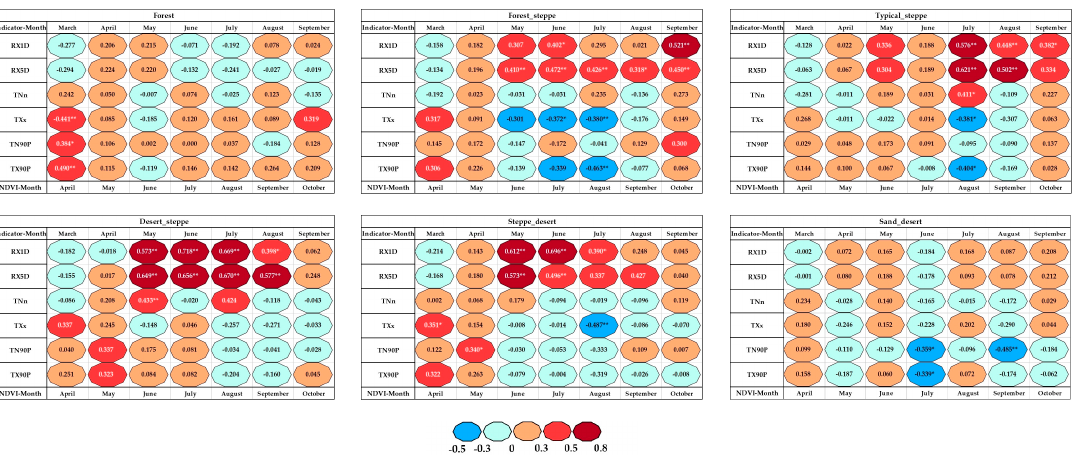
Figure 7. Correlation between monthly NDVI of growing season and extreme climatic indicators from all previous months by different vegetation types during 1982–2015. ** and * indicate p < 0.01 and p < 0.05, respectively.